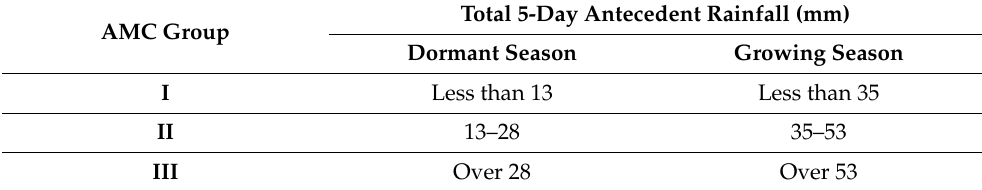
Table 5. Categorization of rainfall of the previous 5 days for the calculation of the initial rainfall losses of the SCS-CN method